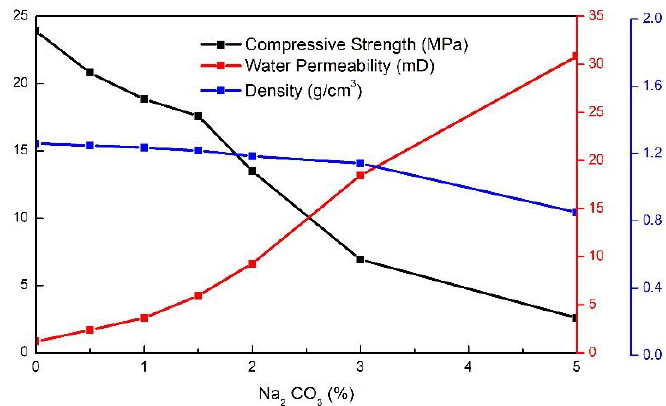
Figure 5. Effect of different mass concentrations of sodium carbonate + aluminum sulfate gas-generating system on the performance of cement stone.